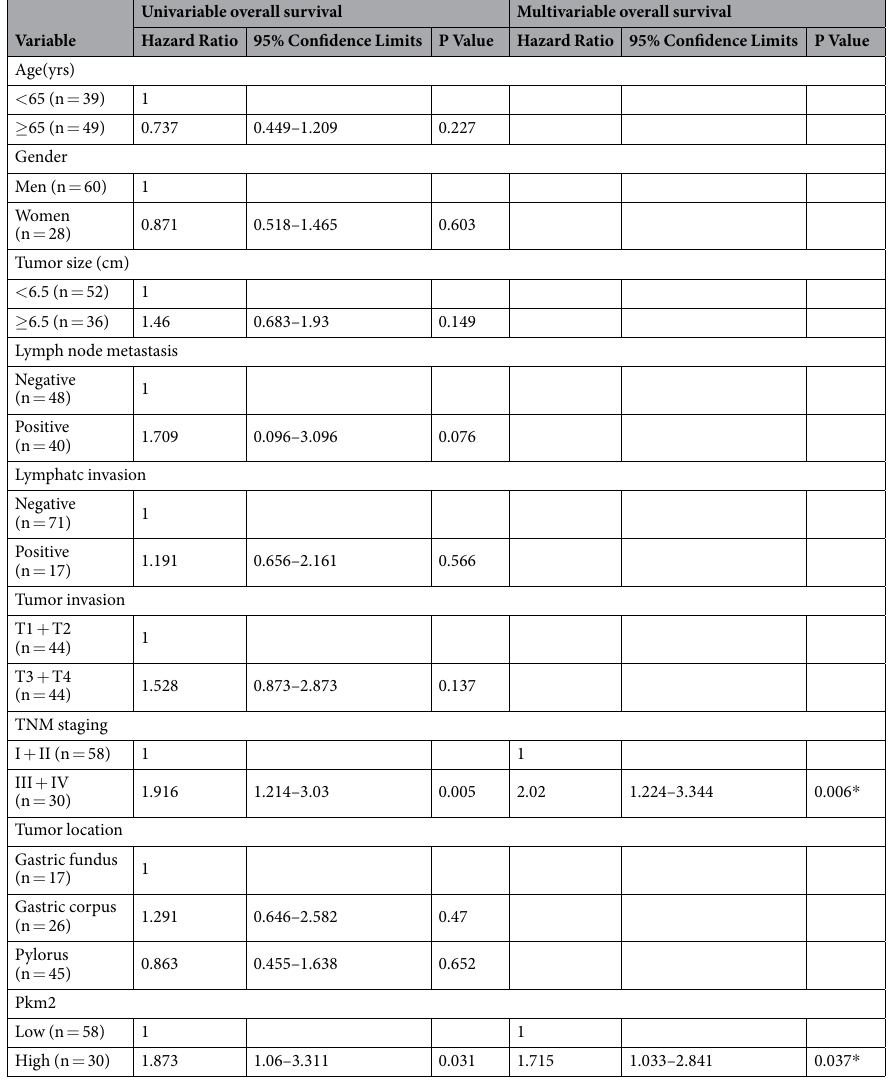
Table 1. Univariate and multivariate analyses of factors associated with survival in 88 cases of gastric cancer. * The difference is significant in multivariate